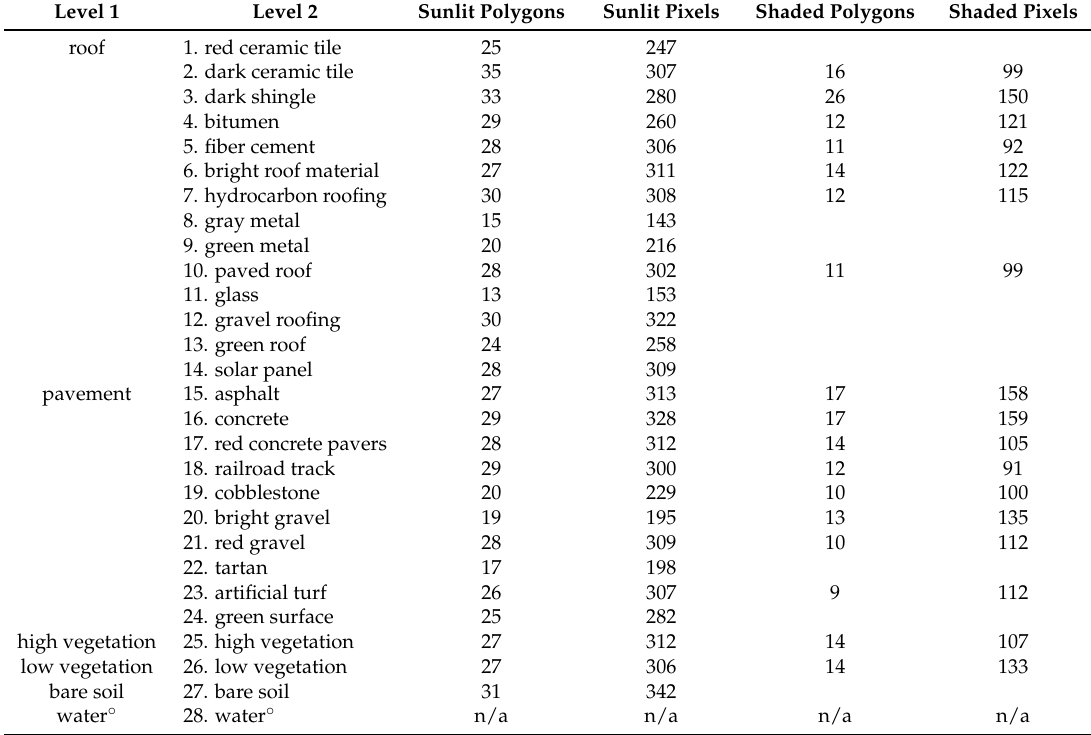
Table 1. Hierarchical classification scheme adopted for this study with indication of number of sunlit-shaded ground truth polygons and pixels for each level 2 material